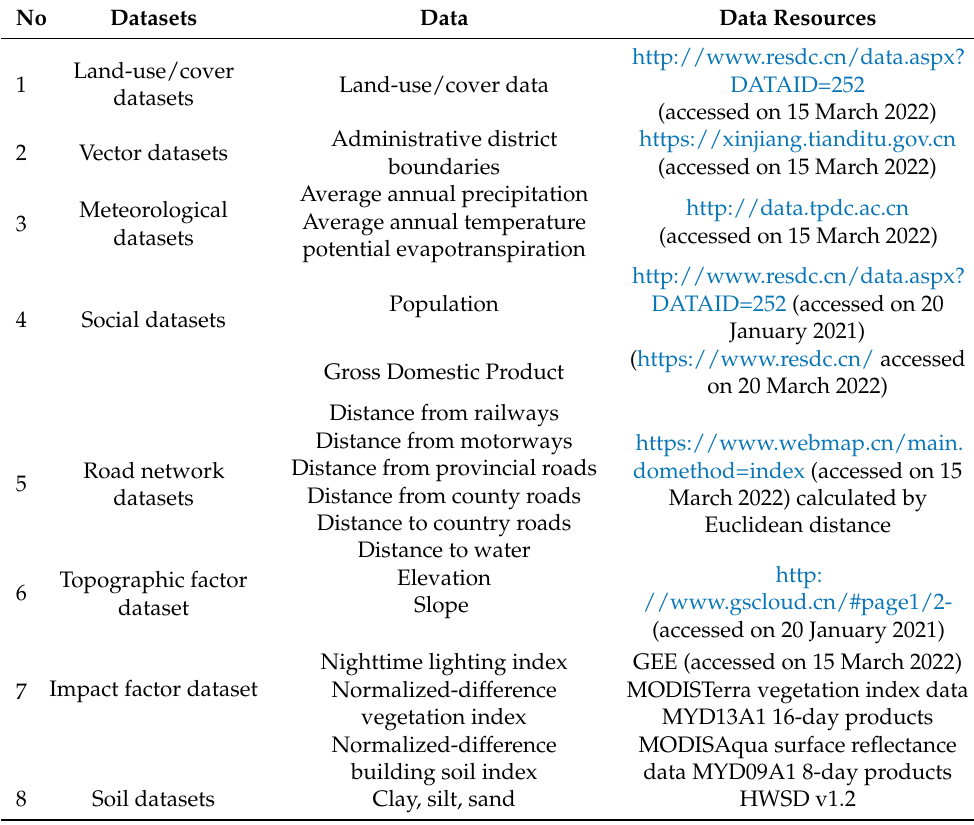
Table 1. Data sources and notes for this